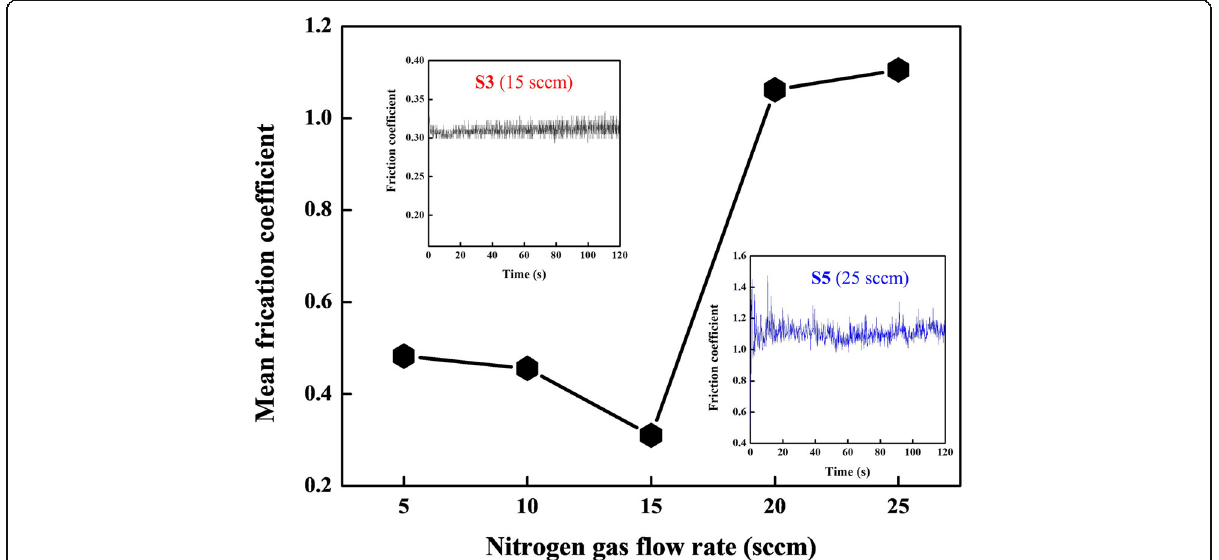
Fig. 6 Mean friction coefficient of Ti-Al-N films deposited at different nitrogen gas flow rates. Inserts are the friction coefficient curve of S3 and S5,